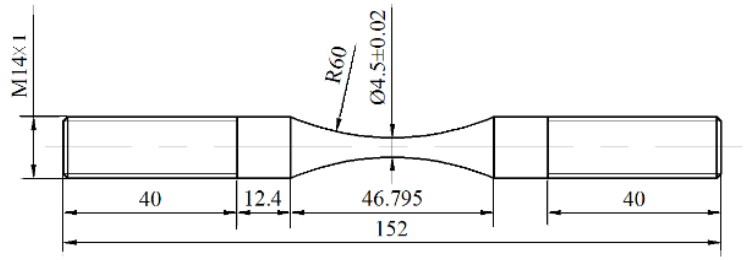
Figure 1. Shape and dimensions of specimen (units: mm).